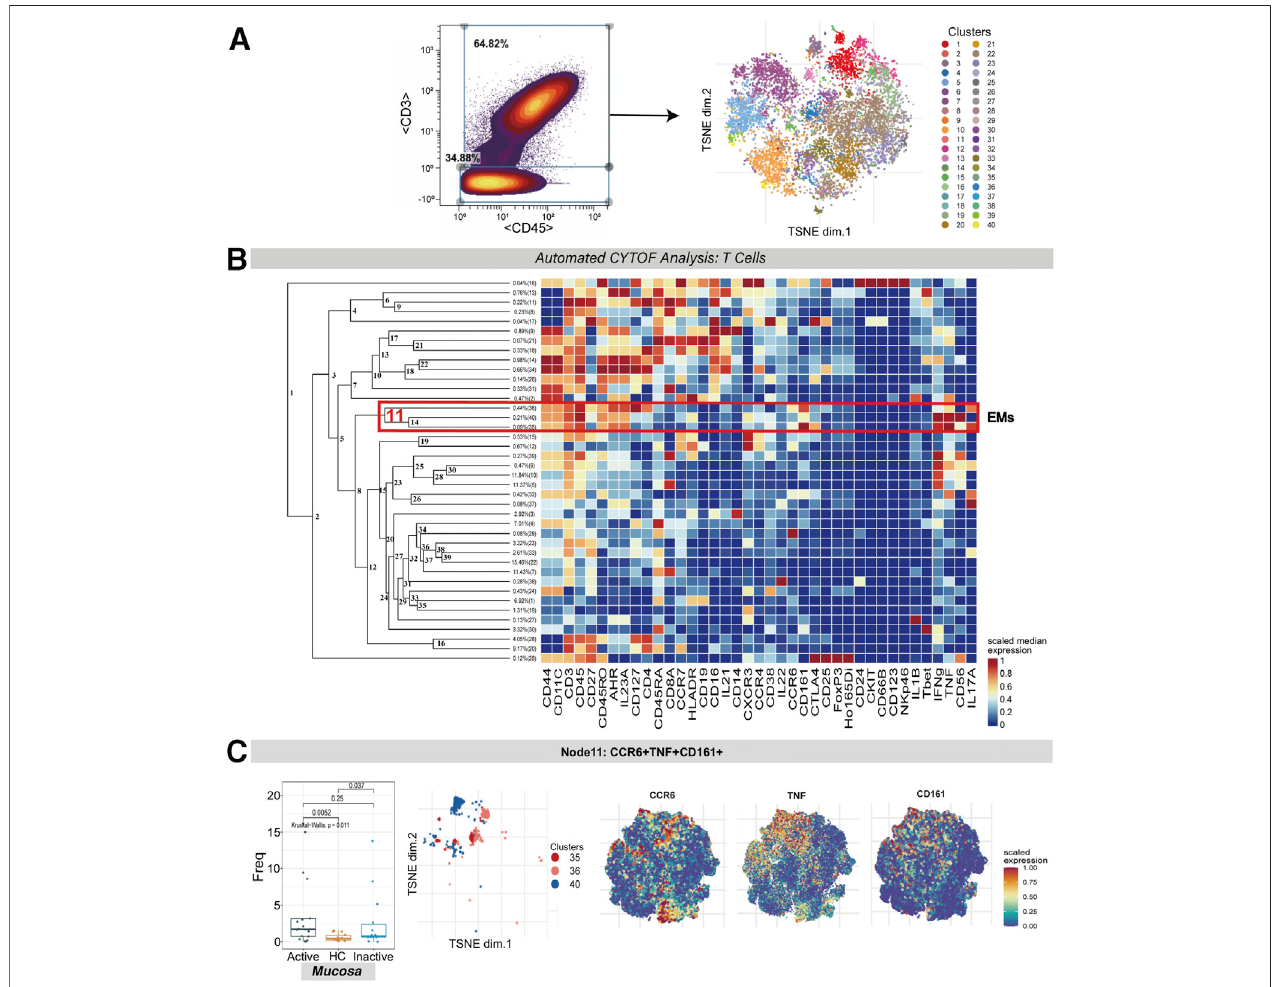
FIGURE 1 | CyTOF analysis of the CCR6 + TNF + CD161 + T cell subset in UC mucosa. (A) Gating steps for screening T cells that were then derived and used for dimensionality reduction (t-SNE) and clustering (FlowSOM) are shown on the left; the t-SNE plot of selected T cells is shown on the right. (B) Cluster dendrogram and heatmap of selected T cells. The branch numbers in the dendrogram corresponded to the cluster numbers in the t-SNE plot (from Panel 1A). The selected nodes highlighted in red are circled with red lines, and the subset names are labeled on the right. The heatmap represents the scaled value for the relative abundance of eachmarkerpercluster.Redrepresentshighexpression,andbluerepresentslowexpression. (C) Theabundanceboxplotofnode11amongthethreegroupsisshown ontheleftwiththeKruskal-Wallistestresults; statisticalsigni fi cancewassetat p < 0.05;thet-SNEplotofnode 11isshownontheright,withCCR6/TNF/CD161marker heatmaps for